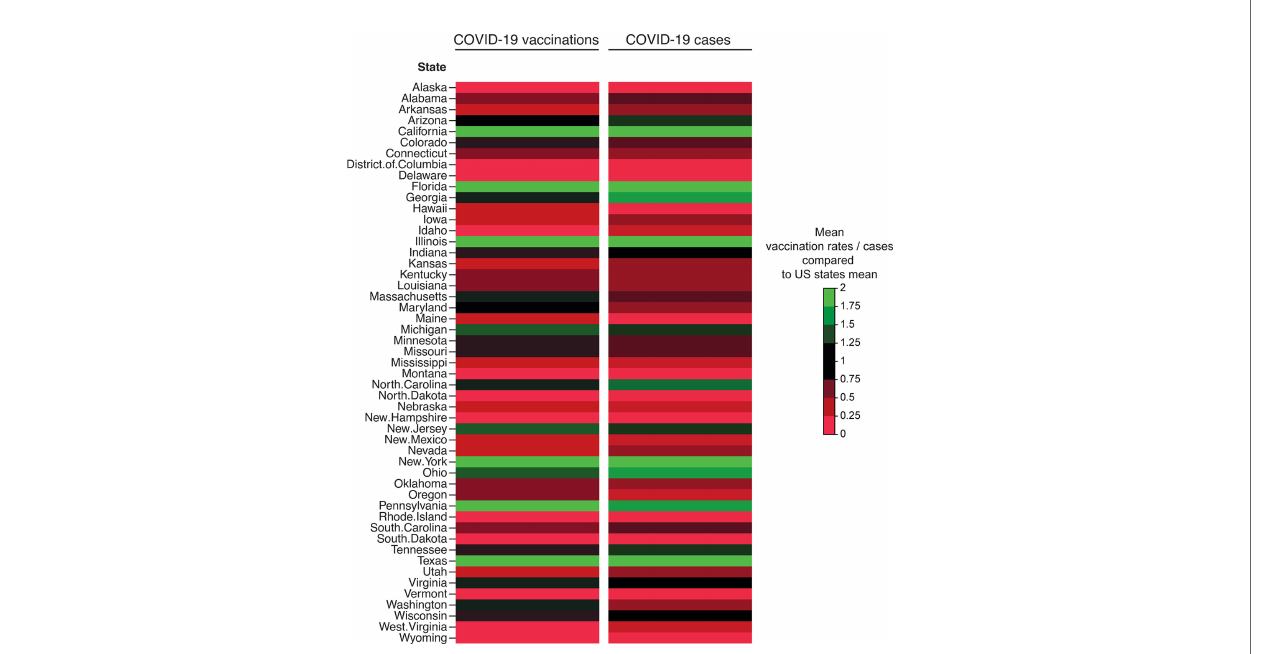
FIGURE 2 | COVID-19 vaccination rates and COVID-19 cases across 51 states in relation to US trends. Means of weekly COVID-19 vaccination rates across 51 between January 10, 2021, and May 31, 2021 are shown as a fraction of the US average. For COVID-19 mean daily cases between June 1, 2020 and May 31, 2021 are depicted as a fraction of US state average. Data are shown as color-coded heatmaps by US states as indicated by the legend (green to